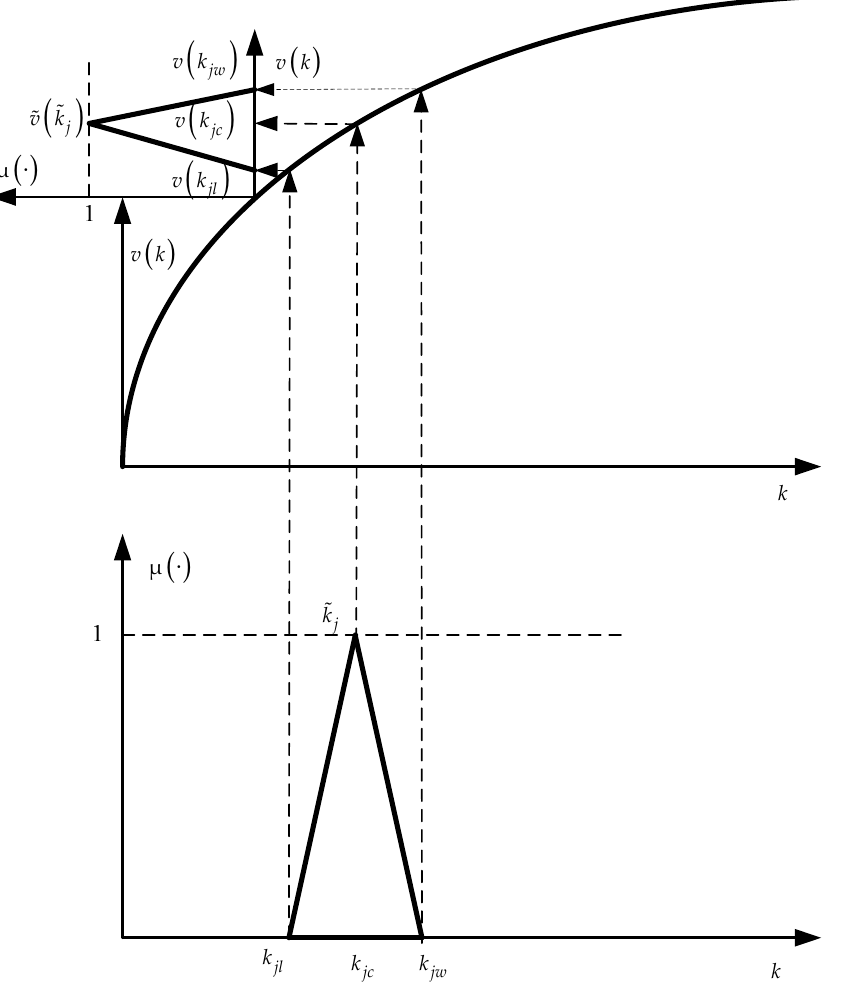
(cid:16) (cid:17) (cid:0) (cid:1) (cid:0) (cid:1) k jl k jc k jw , v , v and the corresponding fuzzy number (cid:101) v